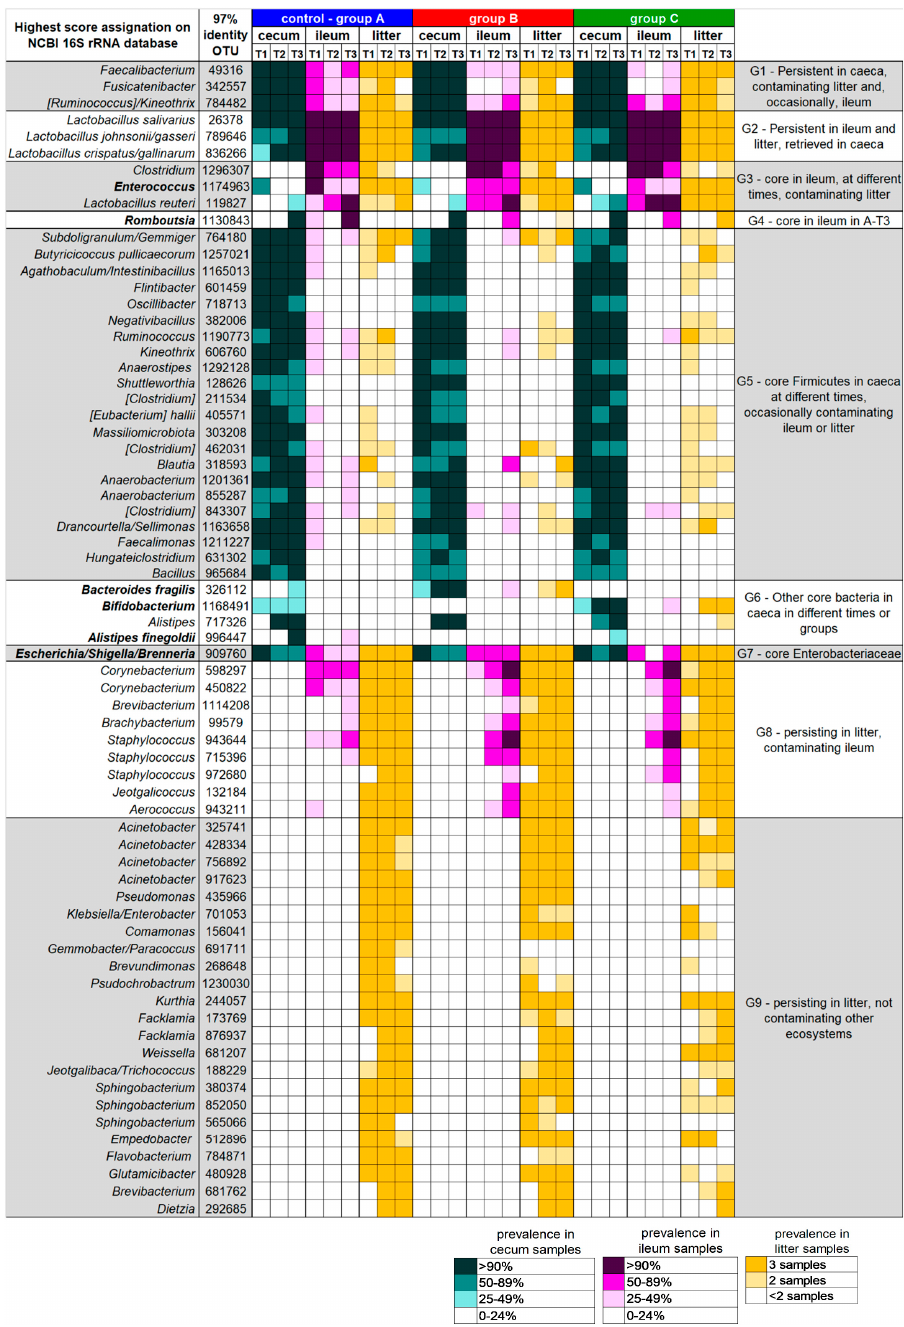
Figure 5. Prevalence of core operational taxonomic units (OTUs) at 97% similarity, in broilers’ caeca and ileum and litter from groups A, B and C, at the three time points (T1, T2, and T3). Operational taxonomic units (OTUs) at 97% similarity were obtained by using the qiime1 pipeline. OTUs detected with a relative abundance > 0.1% in > 90% of samples in at least 1 time point are shown, together with the identification of the highest score alignment against the NCBI 16S rRNA database obtained by using BLAST nucleotide algorithm. Identification is at the level of species only when > 99% similarity was reached, whereas more than one possible genera are reported when equal scores were obtained. Shades of sea-green, purple, and gold are used to indicate the degree of prevalence of the OTUs in all available sets of samples, according to the provided color legend (bottom). OTUs were grouped according to their ecological behavior across the three analyzed ecosystems (caeca, ileum and litter), obtaining groups G1 to G9, as depicted in the right